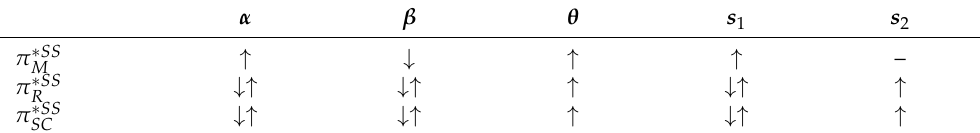
Table 10. The sensitivities of optimal profits to model parameters for Strategy